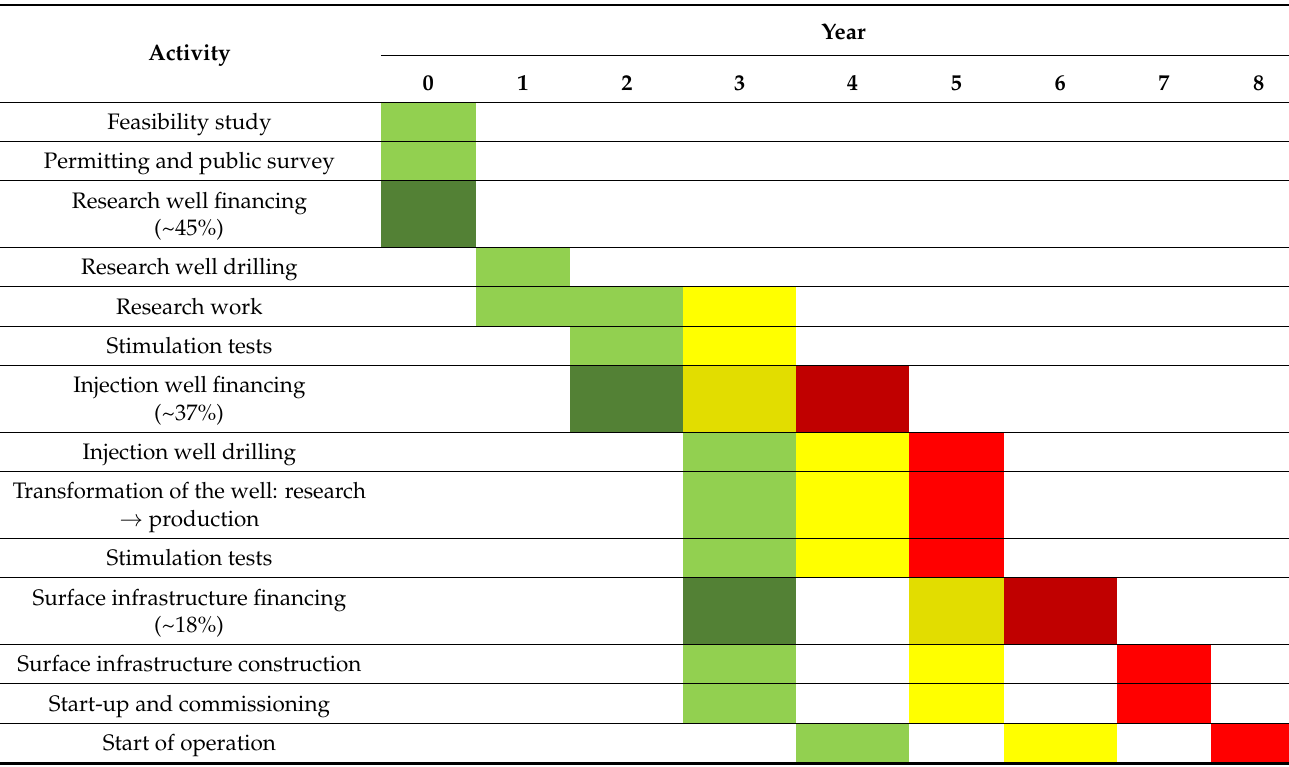
Table 3. Gantt chart for potential development of EGS for Göttingen demo site. Squares with green color—favorable deviation; squares with yellow color—reference case; squares with red color—unfavorable deviation; darker shades— moments for